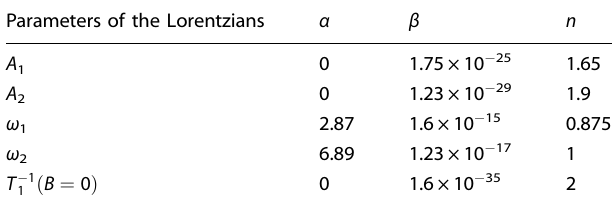
Table 2. Parameters of the polynomial fi ts describing concentration dependence parameters of the double-Lorentzian curve fi tted to the numerical